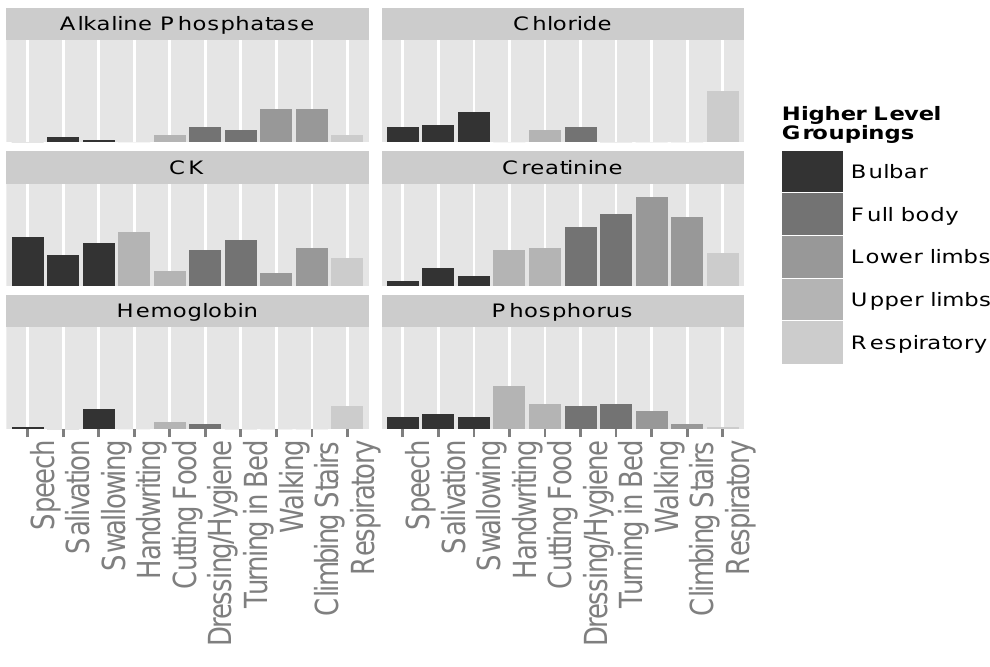
Figure 8. Predictor importance of significant laboratory test variables for the different ALSFRS items. Higher level groupings color the ALSFRS